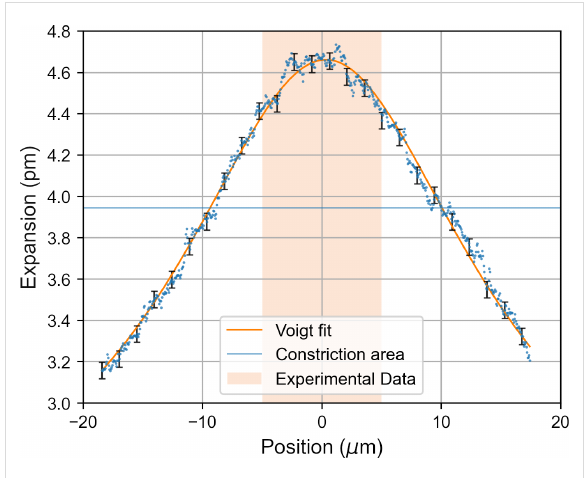
Figure 10: Experimental data showing the expansion profile for a 45.0 mA/ μ m 2 modulation and relative fitting with a Voigt function. The shaded area corresponds to the surface of the constriction. The posi- tion along x was shifted so to have the distribution centered around 0 for visualisation purposes. Estimated errors on the SJEM measure- ment are shown every twenty-fifth data